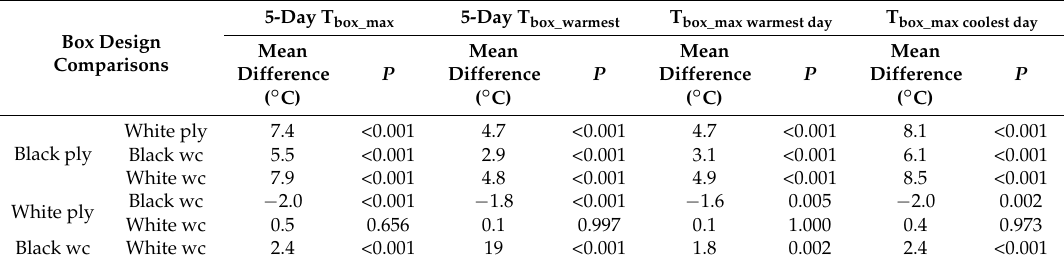
Table 4. Pairwise comparison of temperature in front chambers between box designs for 5-day T box_max